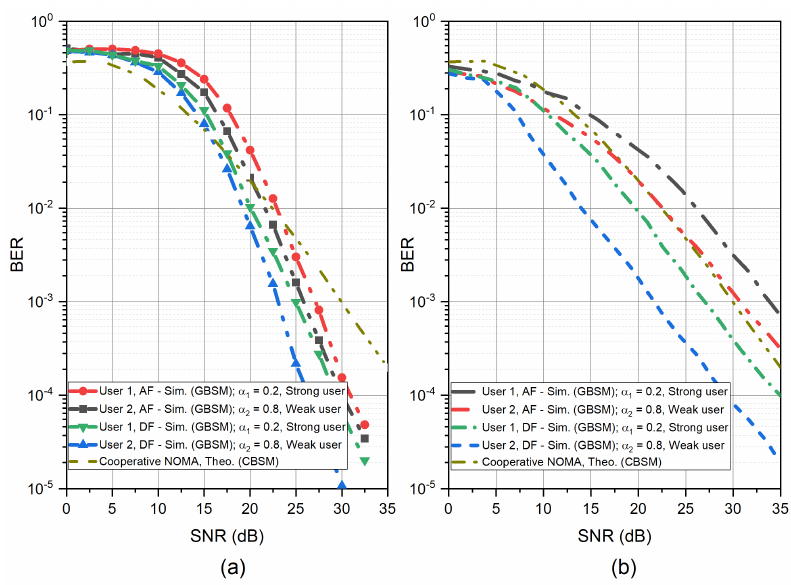
Figure 7. BER of AF and DF schemes of the proposed 3D channel model with ( a ) 3D URA and ( b ) 3D